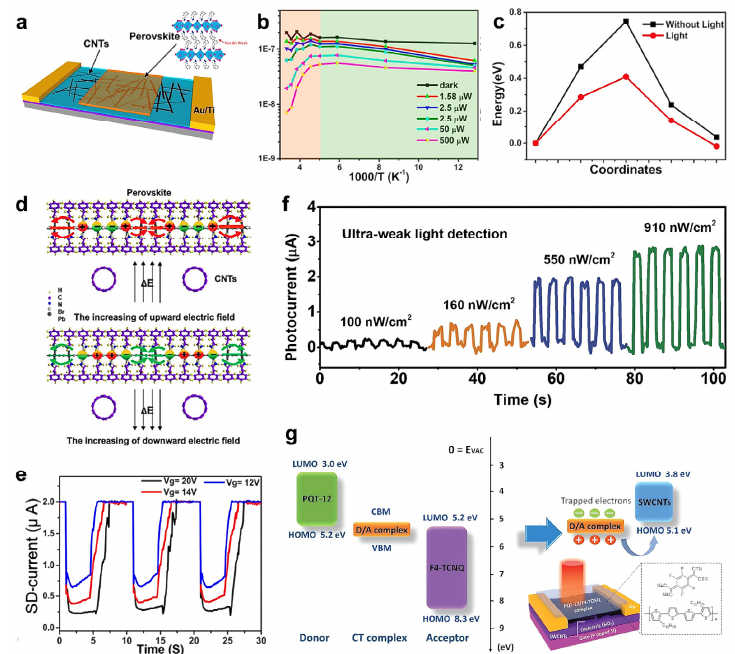
Figure 3. CNT-based photodetector. ( a ) Scheme of a perovskite/CNTs heterojunction transistor. ( b ) I D as a function of temperature under various intensities of light at a fixed V G of − 30 V. ( c ) Ion mi- gration barrier of perovskite with and without light illumination. ( d ) Schematic diagram of in-plane charge migration in lateral direction of perovskite under an electric field. ( e ) I D as a function of time with different V G showing application as photo-memory. ( f ) I Ph of the device irradiating ultra-weak intensities of 100, 160, 550, and 910 nW·cm − 2 light, respectively. ( g ) Band diagram of the donor, ac- ceptor, D/A complex, and SWCNTs film, and the scheme of charge transfer under infrared light. Inset: schematic diagram of the device. ( a – e ) Reproduced with permission from [106]. Copyright Springer Nature, 2019. ( f – g ) Reproduced with permission from [109]. Copyright Wiley, 2021.